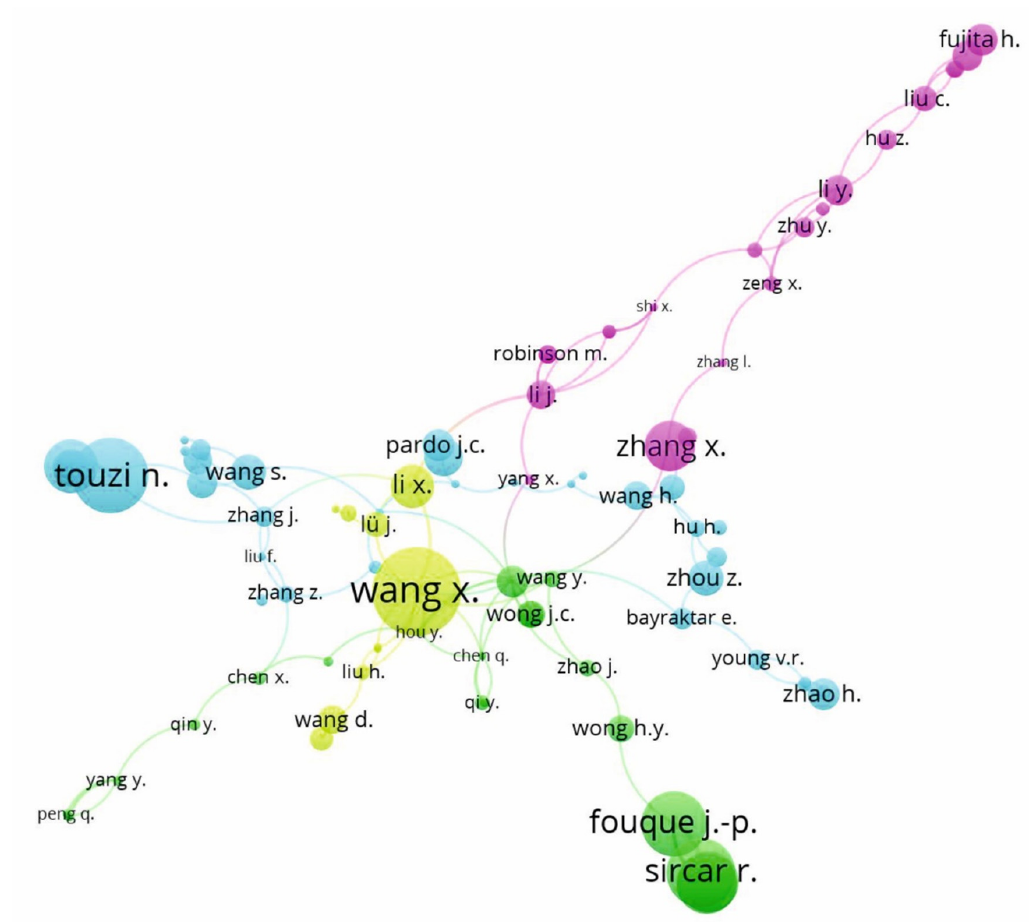
Figure 5. Cooperation network between authors based on co-authorship.